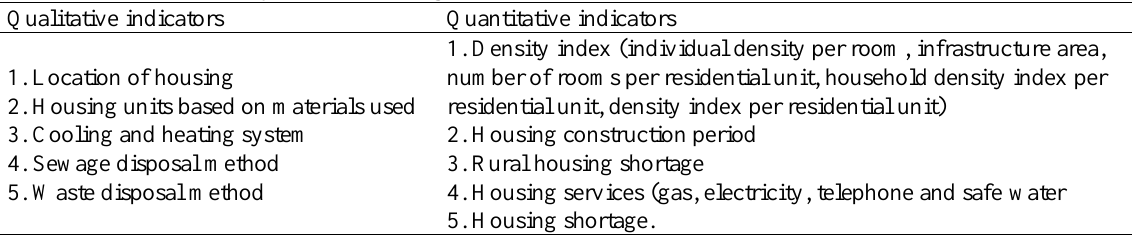
Table 1. Quantitative and qualitative housing indicators Qualitative indicators Quantitative